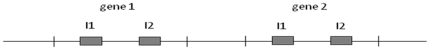
Hypothesis on genomic architecture of myticin-C genes from familiar and population fragment analysis data of intron 1 and intron 2.